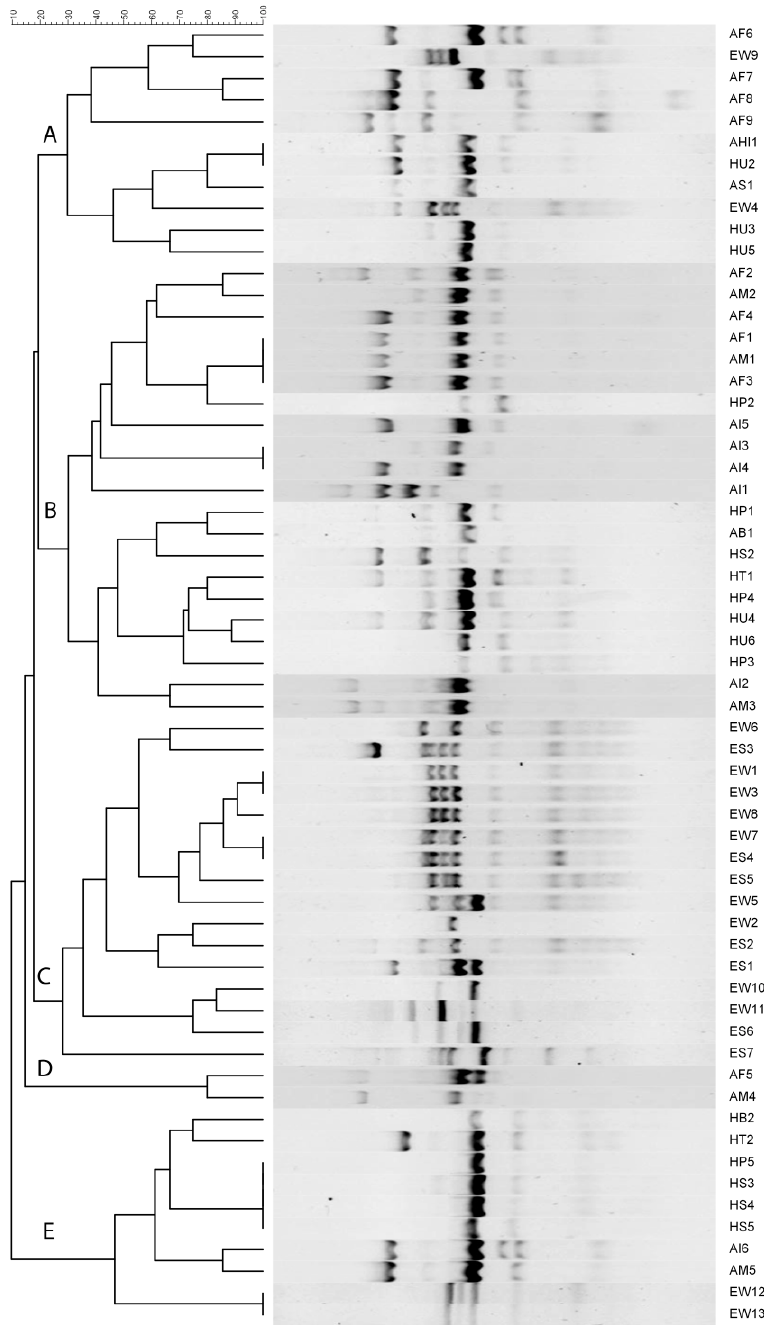
Figure 3. Combined clustering of all the E. coli strains from human, animal, and environmental origins based on ERIC-PCR fingerprinting patterns.